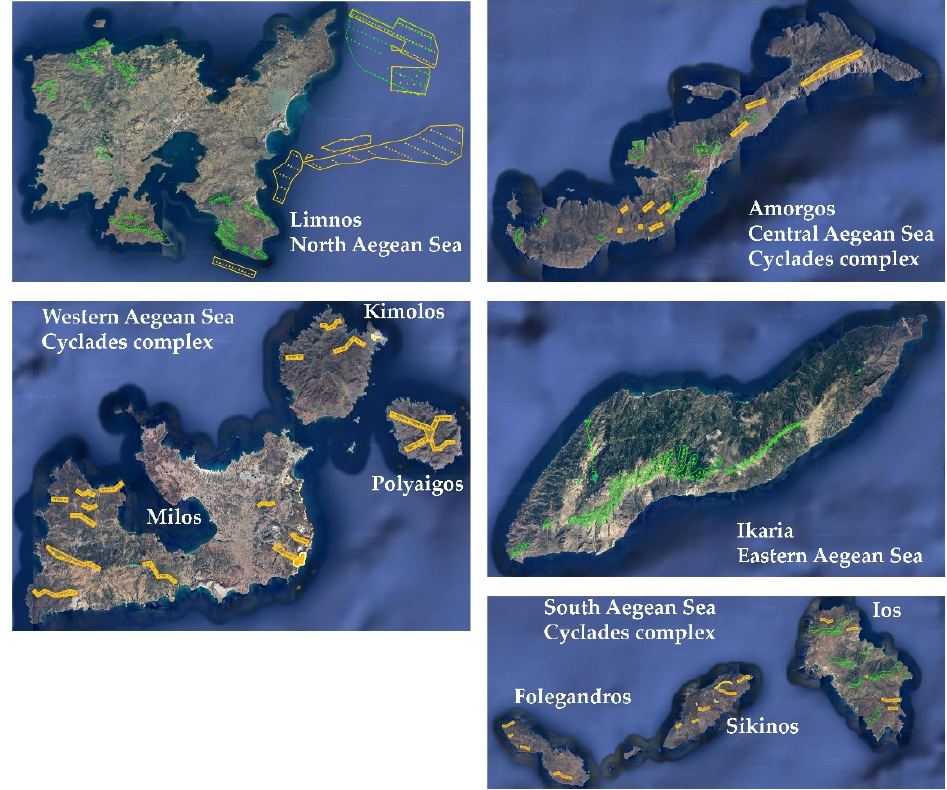
Figure 5. Typical maps from the GIS of RAE with the polygons of the captured land for the installation of wind parks [56].